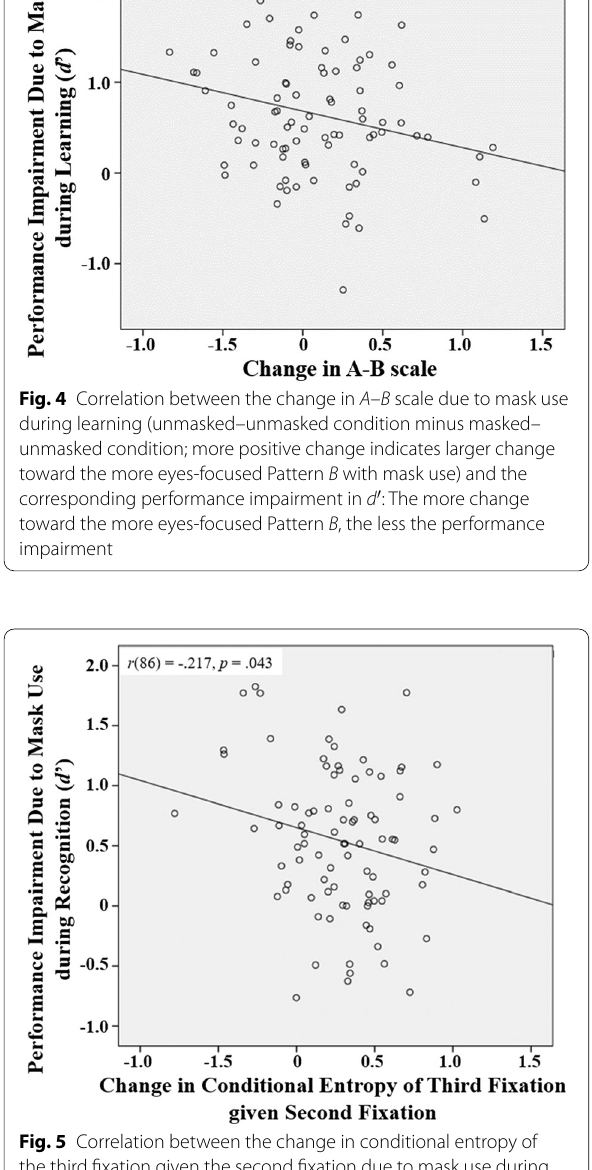
r (86) .217, p .043 (Fig. 5). This correlation was = − =